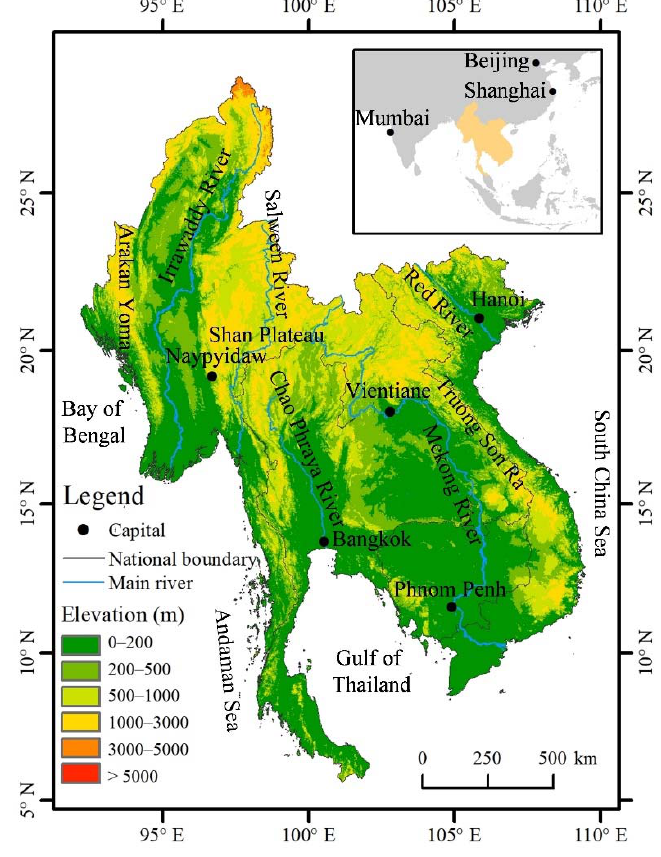
Figure 1. The location and topography of the study area.